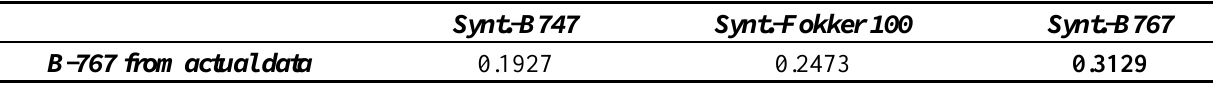
Table 1. Target identification